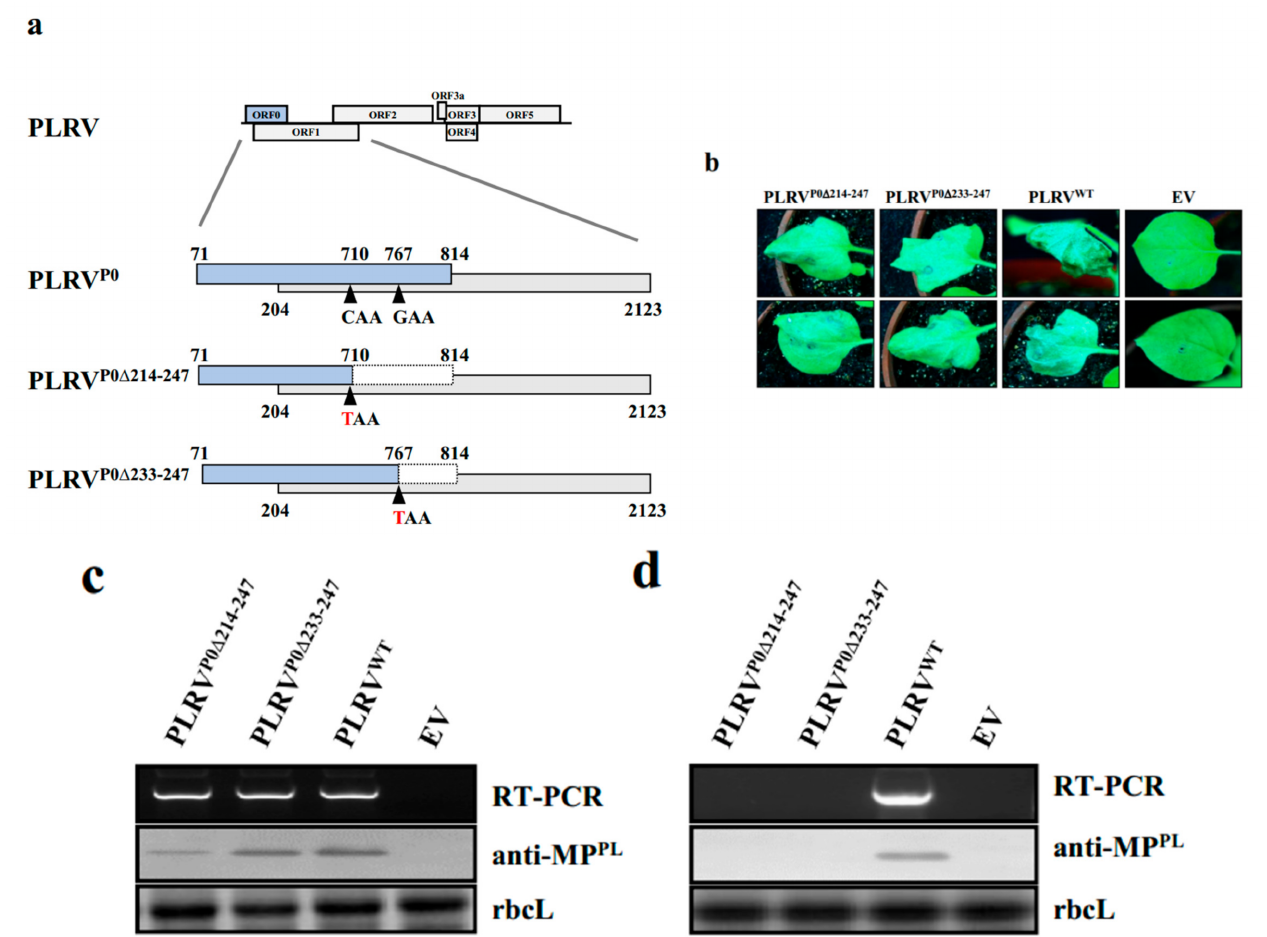
Figure 4. Infectivity analysis of C-terminal truncated mutants of P0 PL obtained from the full-length in- fectious cDNA clone of PLRV (pCB-PLRV) in N. benthamiana . ( a ) PLRV P0 ∆ 214–247 and PLRV P0 ∆ 233–247 mutation is incorporated into the P0 coding sequence without disrupting the P1 sequence. ( b ) In- duction of cell death by C-terminal truncated mutants (PLRV P0 ∆ 214–247 and PLRV P0 ∆ 233–247 ) in agro- infiltrated N. benthamiana leaves at 7 dpi. Empty pCB vector (EV) and wild-type (PLRV WT ) were used as negative and positive controls, respectively. ( c ) RNA and protein determinations from virus-inoculated N. benthamiana leaves at 3 dpi as assessed by RT-PCR using PLRV-specific primers and Western blotting analysis using a PLRV-MP-specific antibody (anti-MP PL ). ( d ) RNA and protein determinations from the upper leaves of respective N. benthamiana plants at 14 dpi as assessed by RT- PCR using PLRV-specific primers and Western blotting analysis using a PLRV-MP-specific antibody (anti-MP PL ). Stained rubisco is shown to indicate equal lane